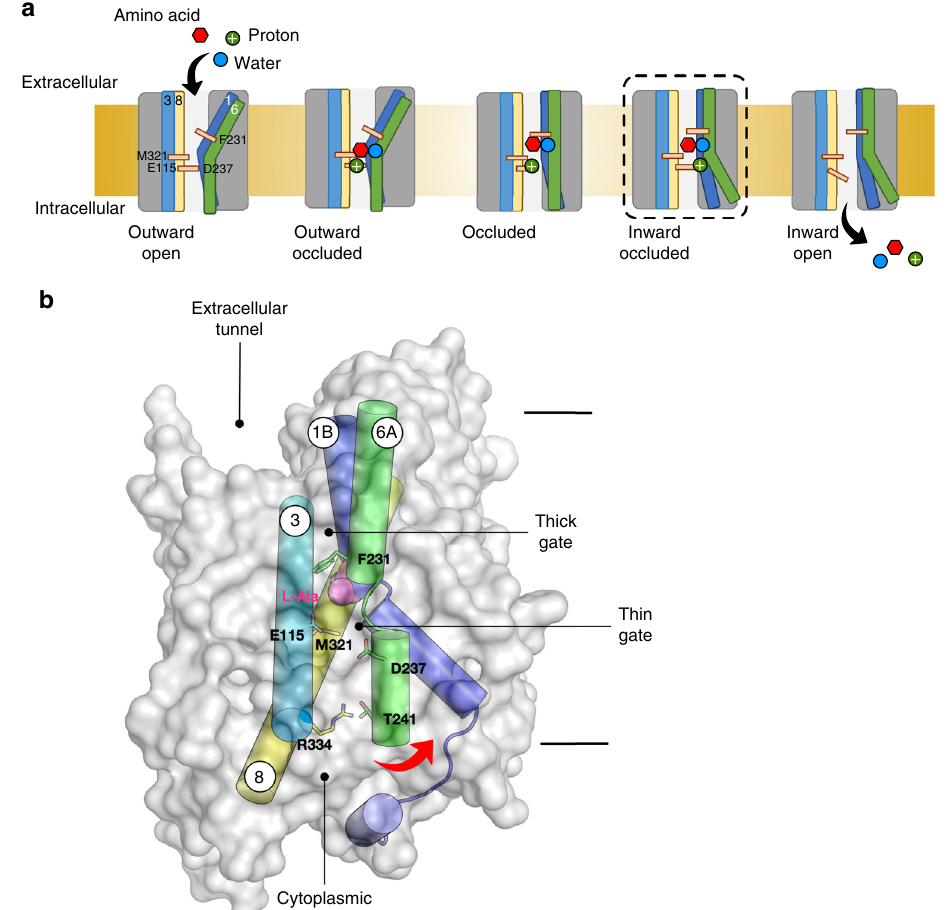
Fig. 6 A model for alternating access transport in GkApcT. a Schematic representation of alternating access transport in GkApcT. Starting from an outward facing state the transporter must reside in a conformation that facilitates access of protons, water and amino acid to the binding site. Binding of amino acid causes conformational changes in TM1 and 6 that act to close the extracellular gate. This may be facilitated by water binding to TM1 and movement of F231 that facilitates formation of the occluded state. Further conformational changes are predicted to occur that move the transporter into a fully occluded state, before the intracellular gate starts to open 46 . Our crystal structure likely represents this ‘ inward occluded ’ state, where the intracellular gate is still present, but held shut through side chain interactions rather than main chain packing. In GkApcT E115 is likely protonated in this state, holding TM6 in close approximation to TM8, where M321 forms part of the intracellular gate. Proton release from E115 causes the water mediated interaction to D237 to break, and TM6 to swing away from TM3 and 8, opening the binding site to the inside of the cell and releasing the bound amino acid and possibly a water molecule. b Structure of GkApcT shown in molecular surface representation with the predicted gating helices shown. Our data suggest that movement of TM6 away from TM3 and 8 opens the binding site to the interior of the cell, and facilitates release of the bound amino